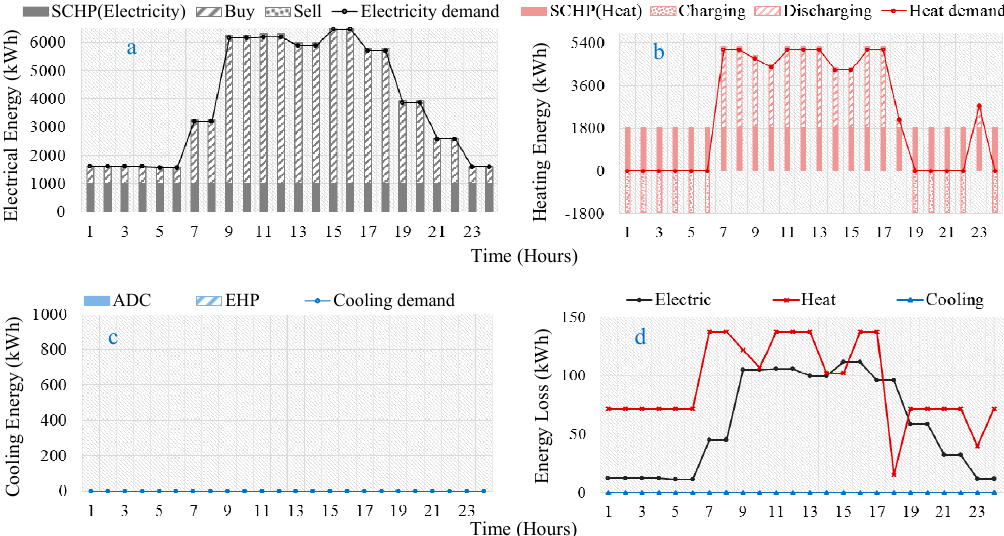
Figure 12. Energy balancing of BMG3 in winter season: ( a ) electrical energy; ( b ) heating energy; ( c ) cooling energy; and ( d ) energy loss.